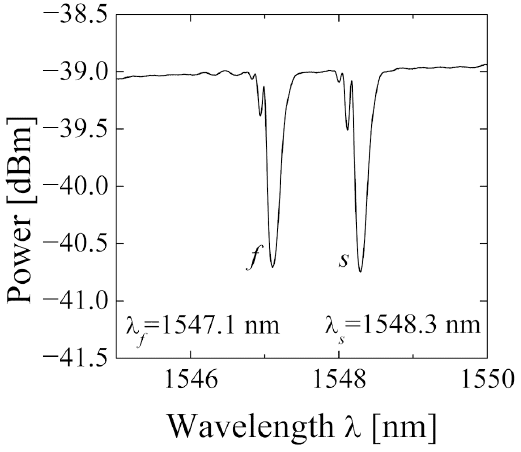
Figure 3. Spectral transmission characteristic of fiber Bragg gratings #1 (FBG1) written in SH2 optical fiber.